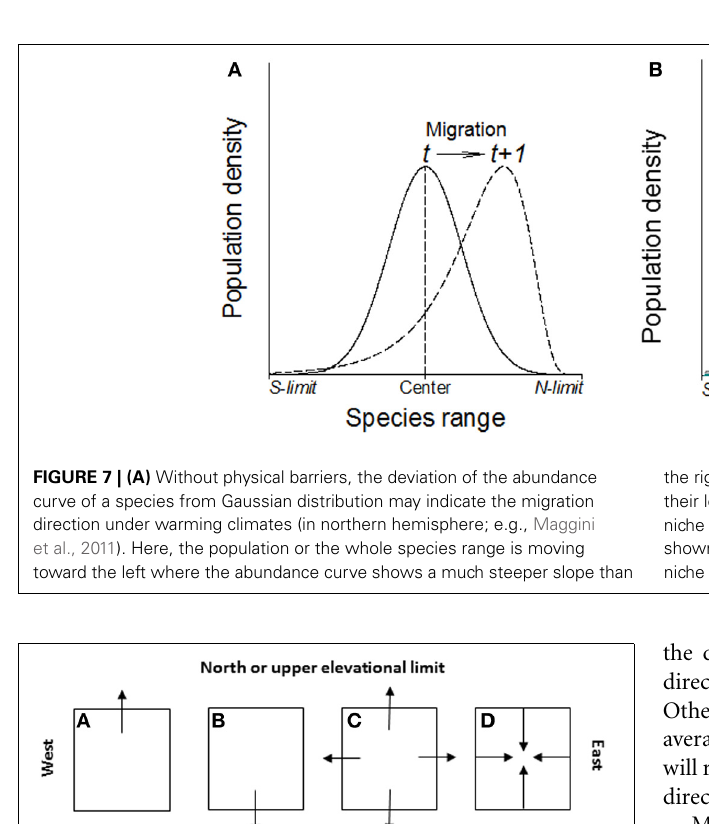
FIGURE 8 | Four likely scenarios of the species’ patch or range dynamics in major cardinal directions (i.e., A: shift northward, B: shift southward, C: expansion, and D: contraction) and their dependence on the initial locations of species introduction relative to the niche space and future climate change (see Figure 7). These cardinal directions are selected because they represent (1) the latitudinal gradients ( S-N ) along which the glaciations took place in the geological past and climate warming occurs and/or (2) the distance to the oceans or elevational changes ( E-W , e.g., across North America or eastern